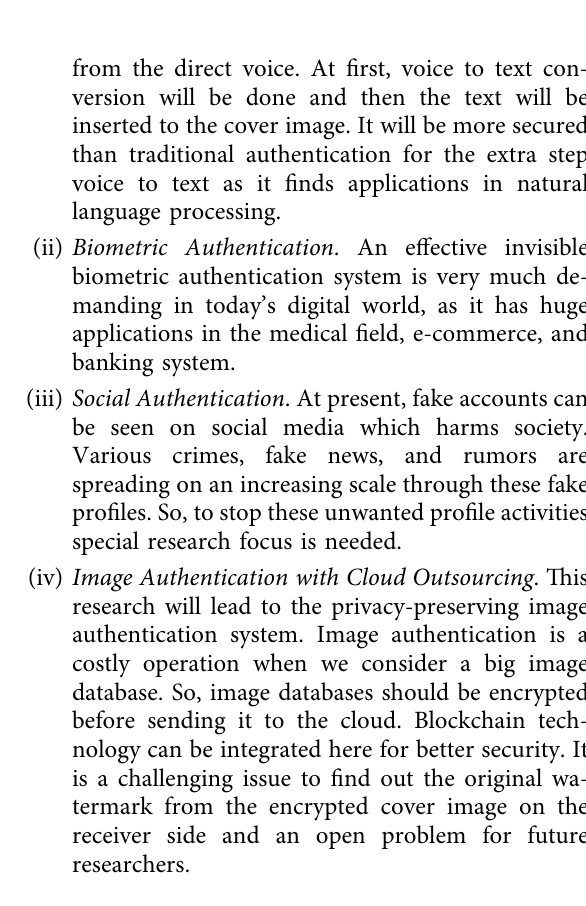
Figure 5: Applications of hybrid digital image watermarking